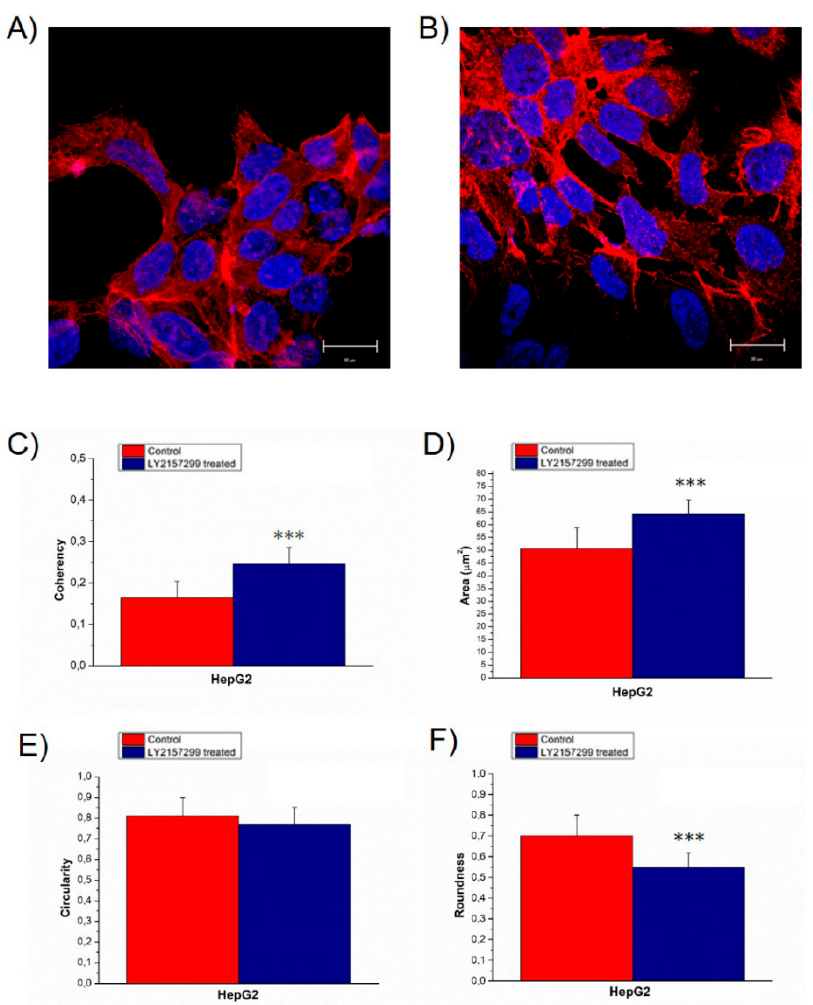
Figure 1. Representative confocal images of HepG2 CTR ( A ) and transforming growth factor (TGF)- β treated for 48 h HepG2 TGF- β 1 ( B ), the scale bar in the figures correspond to 20 µm. In the panel, the value of F-actin coherency ( C ), nuclear area ( D ), circularity ( E ) and roundness ( F ) were reported. The analysis of F-actin and nuclear morphology of control and TGF- β 1 treated HepG2 cells, were performed by using ImageJ software. Results were statistically significant for p < 0.005 (indicated as ***).